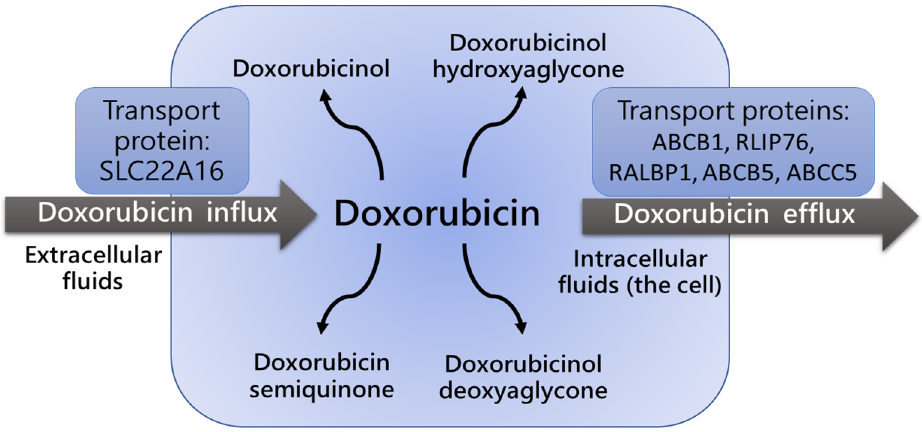
Figure 2. Influx and efflux of doxorubicin is defined by activity of ABCB1/MDR1 transport [39–42]. ABCB1/MDR1 protein expression level and polymorphism determine the intensity of doxorubicin transport.